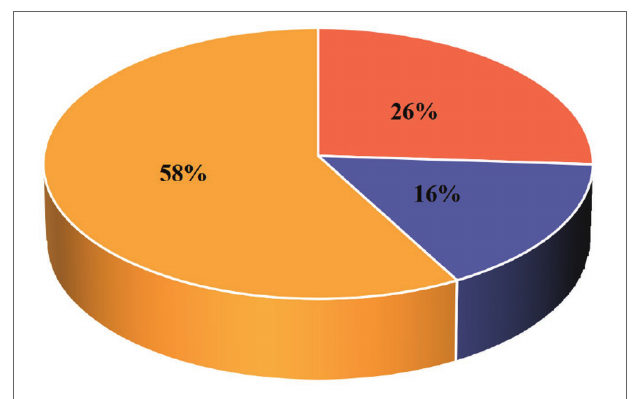
FIGURE 8 | Sentiment analysis of online comments on public opinion events.